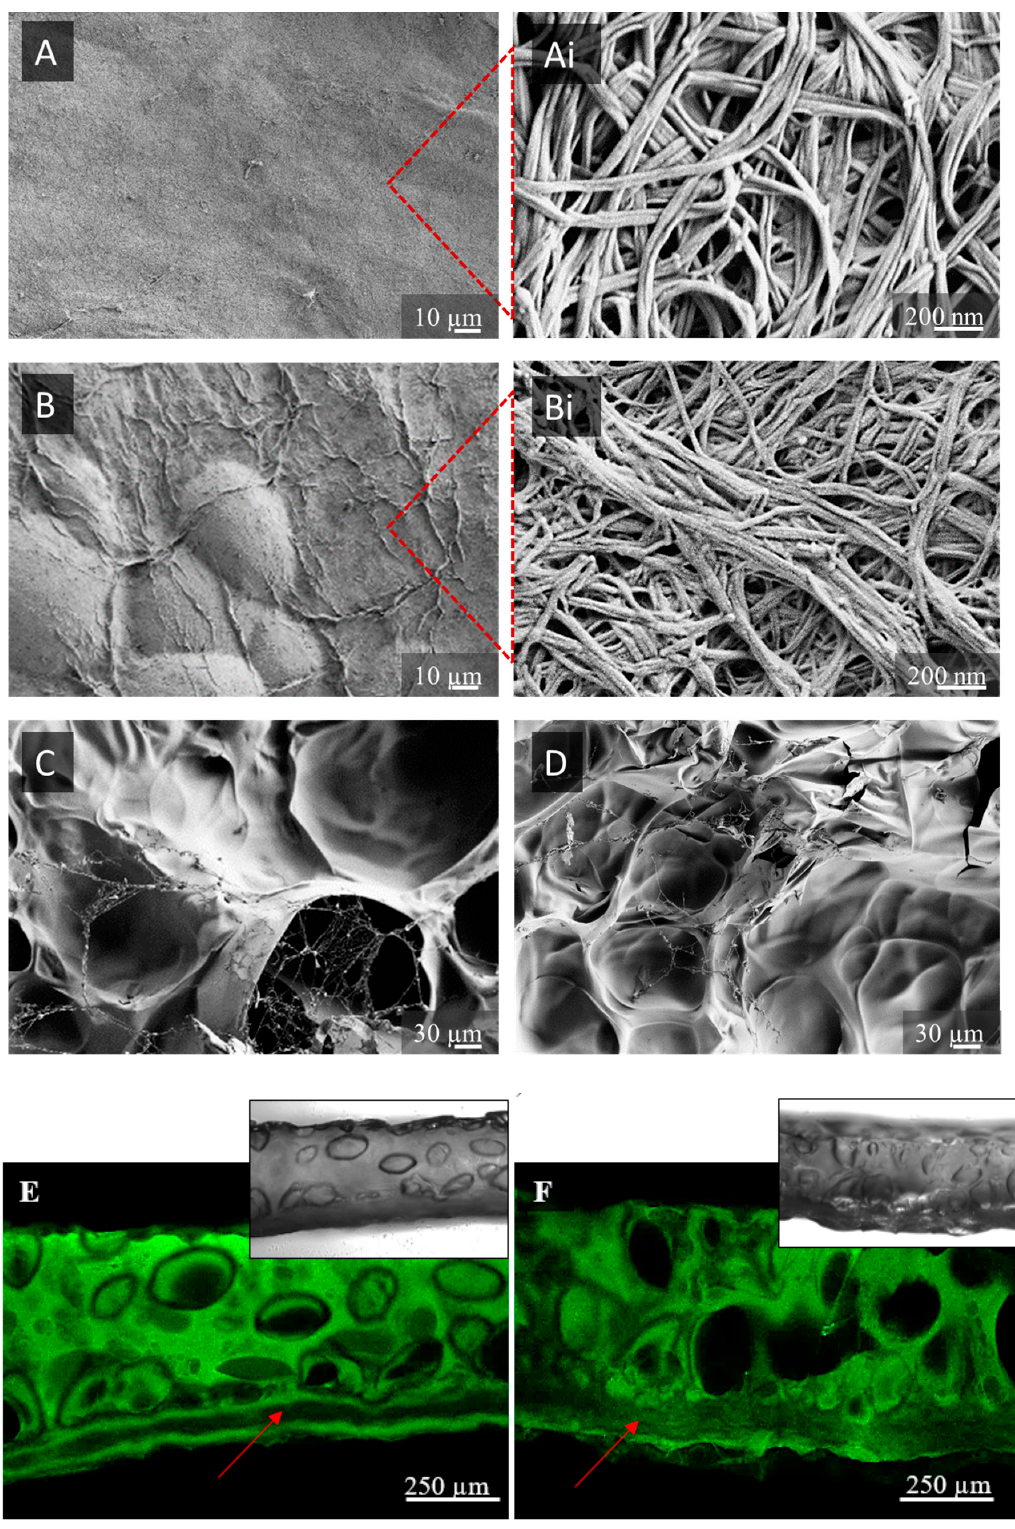
Figure 2. Scanning electron microscopy (SEM) micrographs of BC before ( A , Ai ) and after ( B , Bi ) oxidation with 2% sodium periodate; and coating with 5% GEL ( C ); and 10% GEL ( D ); and confocal fluorescence microscopy (CFM) images from top cross-section of BC–GEL membranes containing nontreated ( E ); and 2% oxidized BC ( F ). Respective bright field micrographs were inserted into fluorescence (FITC)-aided images.